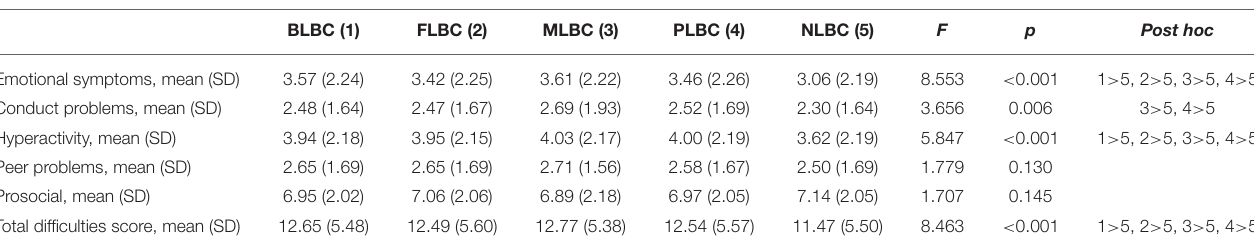
TABLE 2 | Group differences in terms of SDQs, mean